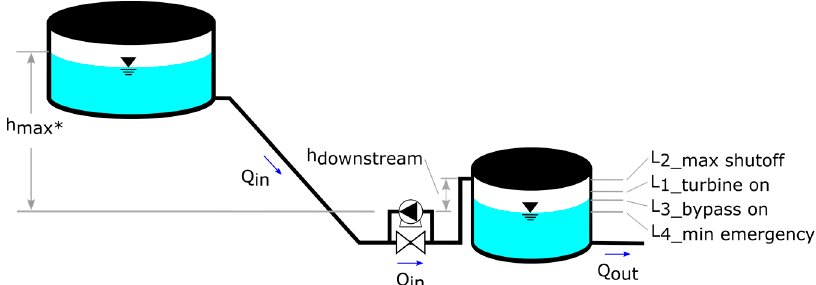
Figure 2. Visual explanation of some key parameters used in the method, as introduced in Sections 2.2 and 2.5. * Note that h max depends on the current water level in the upstream tank, which is why the measurement of h 1_upstream and h 2_upstream should be conducted when the upstream tank is known to be at its typical lowest level.